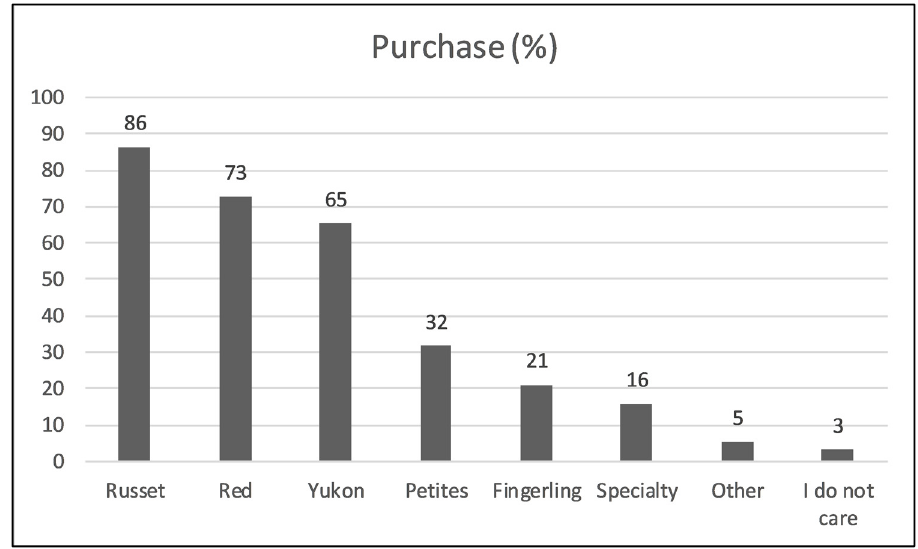
Figure 7. Consumer’s purchase percentage for different varieties ( N = 95). Question —Which potato varieties do you normally purchase? Please check all that apply.